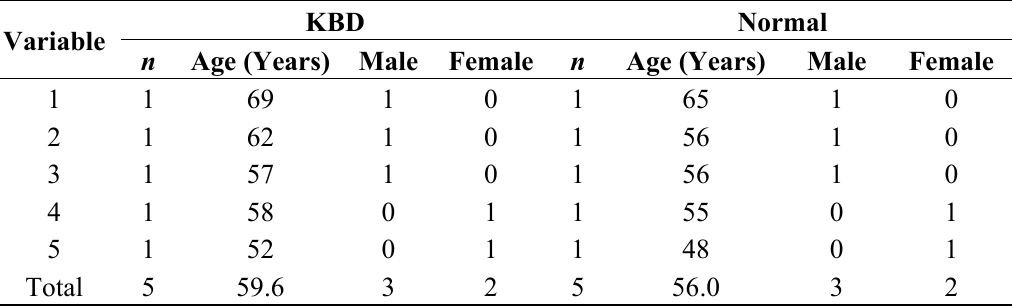
Table 4. Characteristics of the patients with KBD and the controls used for quantitative RT-PCR